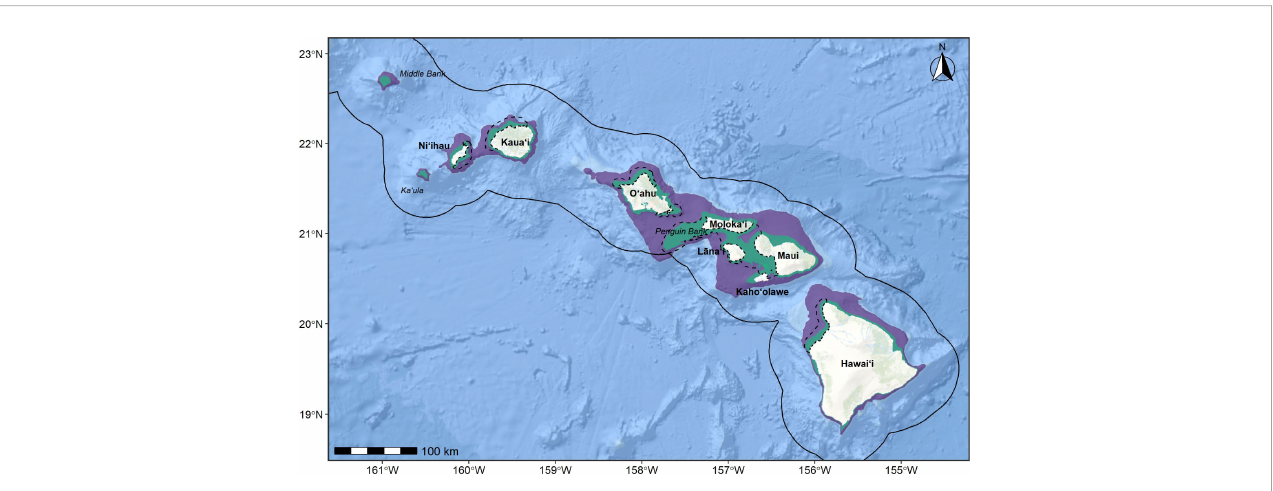
FIGURE 8 Revised parent BIA boundary (purple polygon) for humpback whales represented as the 1,000-m isobath around all main Hawaiian Islands as well as Middle Bank, and child BIA boundary (core range; green polygon) represented as the 200-m isobath within this area. BIAs span months December through May. The inner (shoreward) boundary for both BIAs is de fi ned by a 50-m distance band from shore. Humpback whale breeding area perimeter is represented by the solid black line. Established R-BIA boundaries delineated in Baird et al. (2015) are shown in dashed black lines. Total area of the parent BIA = 23,042 km 2 and child BIA is 6,679 km 2 . Basemap image is the intellectual property of Esri and is used herein with permission. Copyright © 2022 Esri and its licensors. All rights